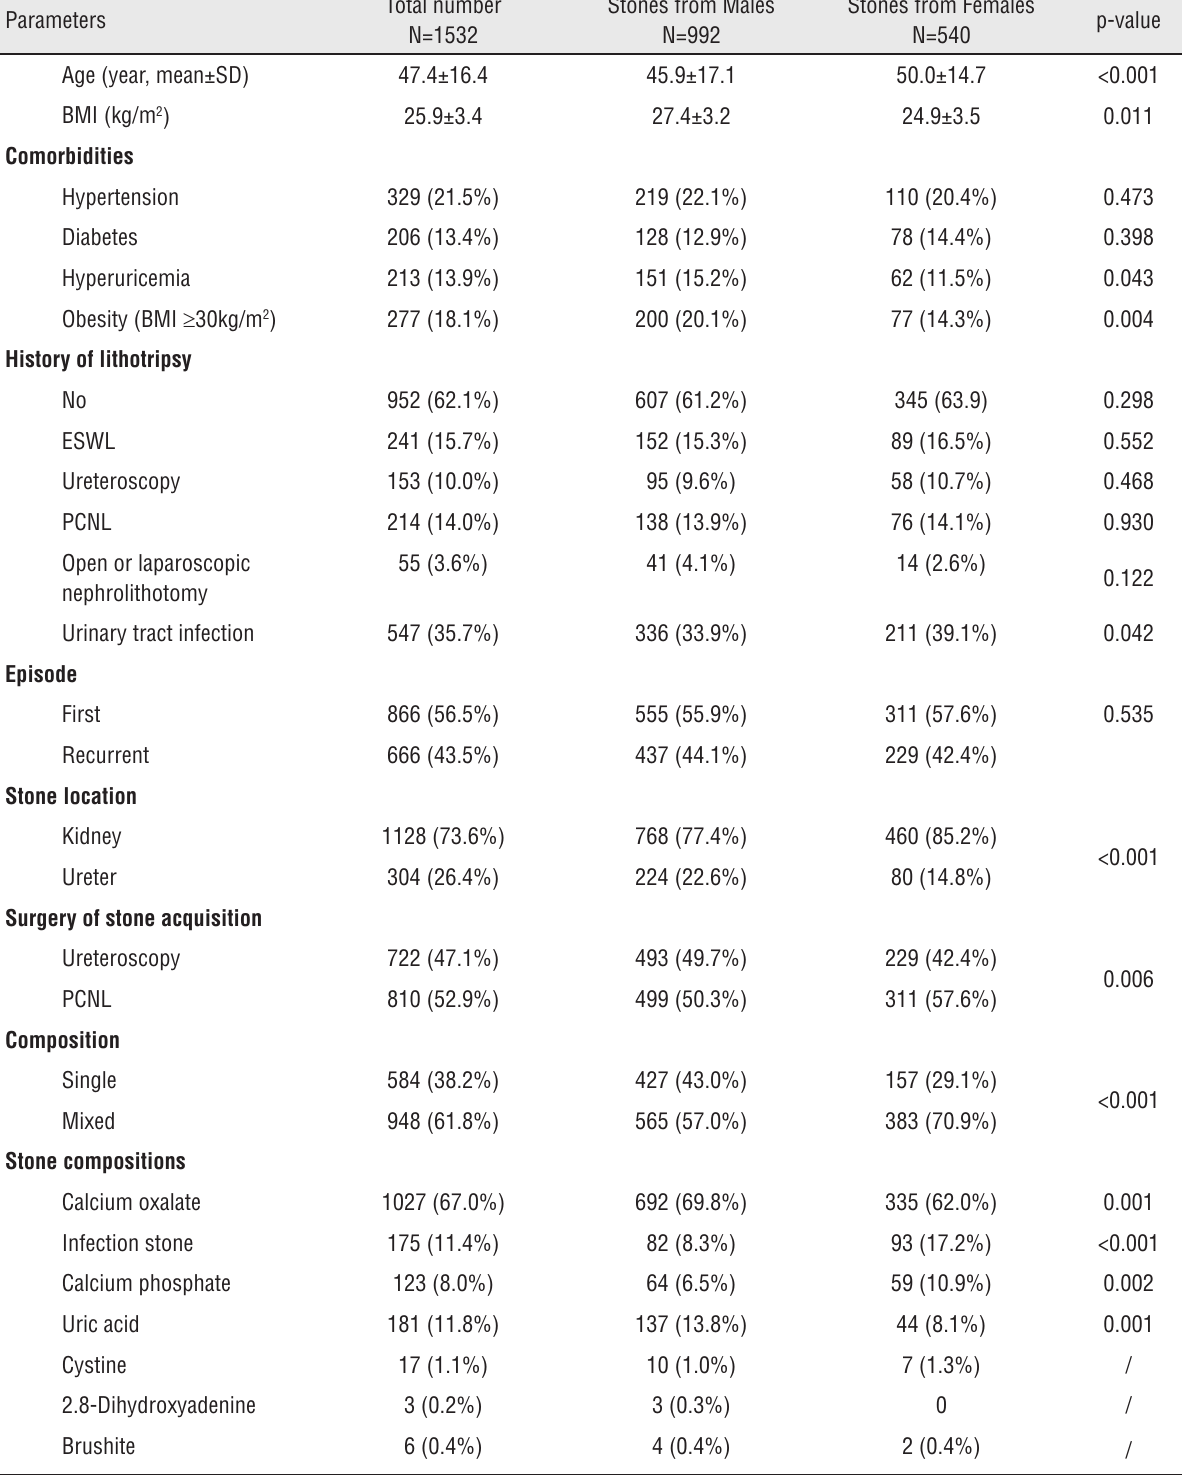
Table 1 - Characteristics of patients and stone compositions stratified by